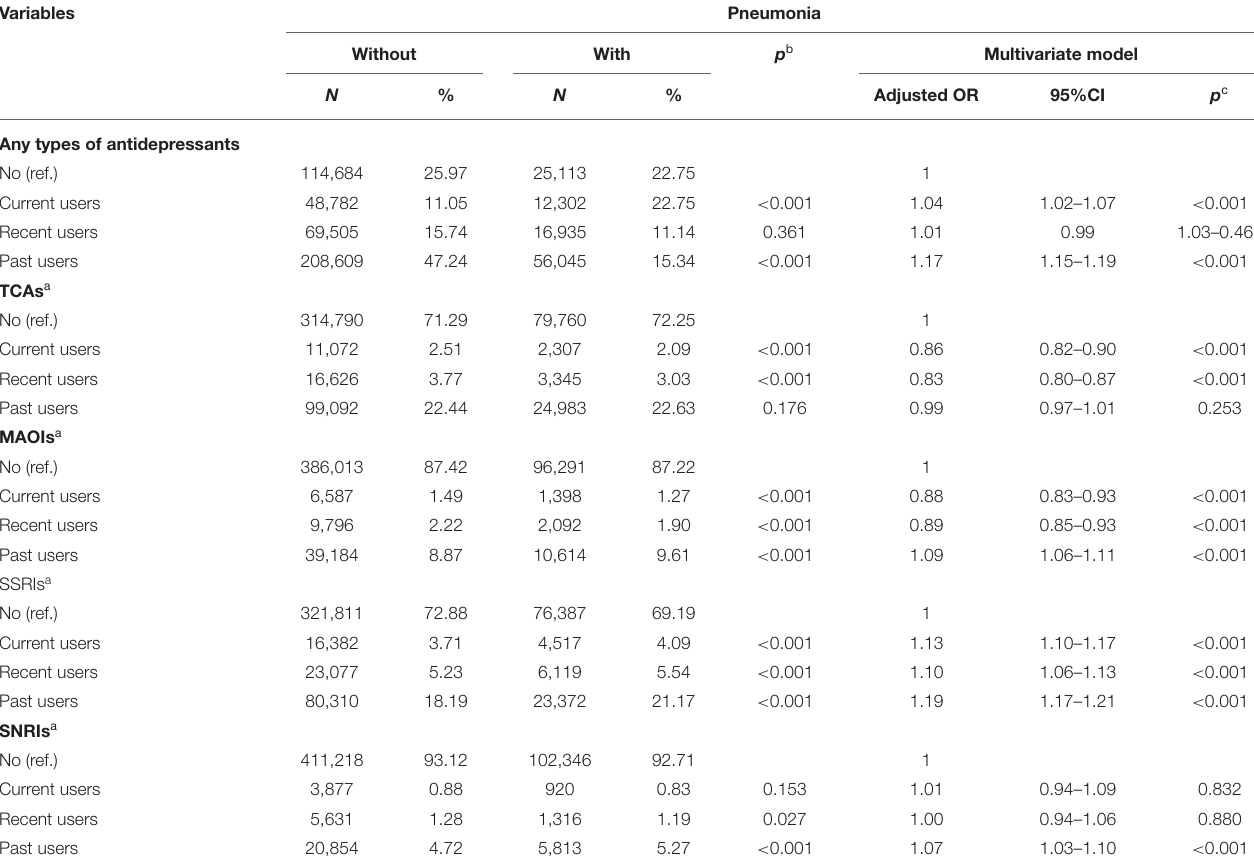
TABLE 2 | The incidence rate of pneumonia with antidepressants use. Variables Pneumonia